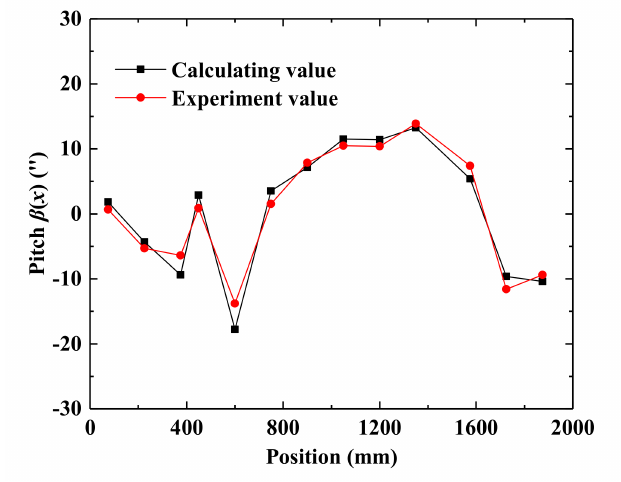
Figure 7. Results comparison of pitch β ( x